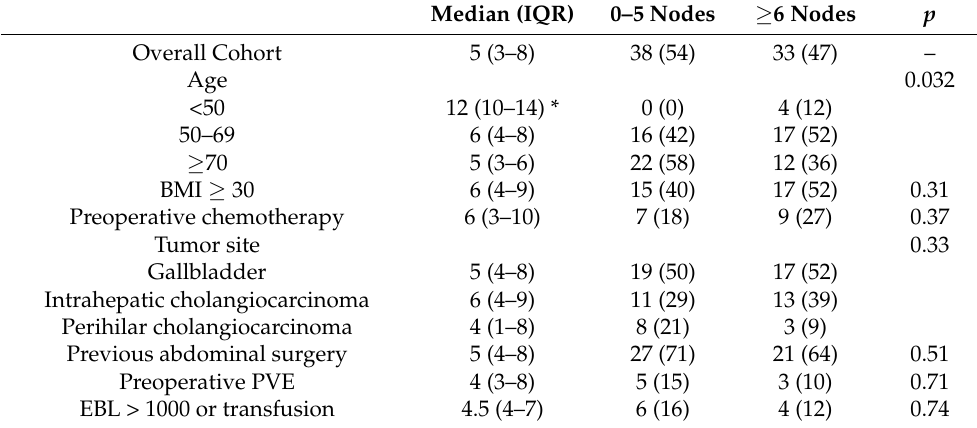
Table 3. Predictors of ≥ 6 nodes retrieved with complete portal lymphadenectomy ( n =